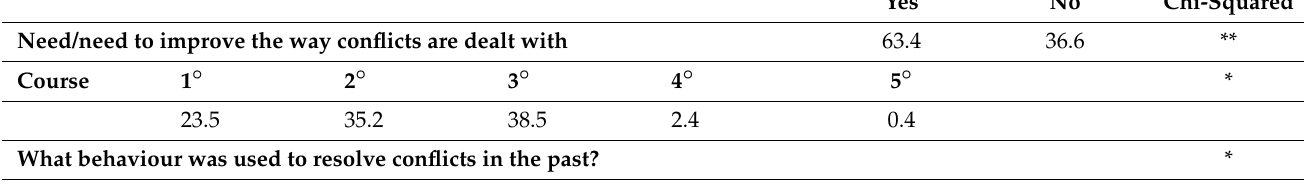
Table 3. Results of cross-tables with the dependent variable: positive valuation of the conflict. Yes Chi-Squared